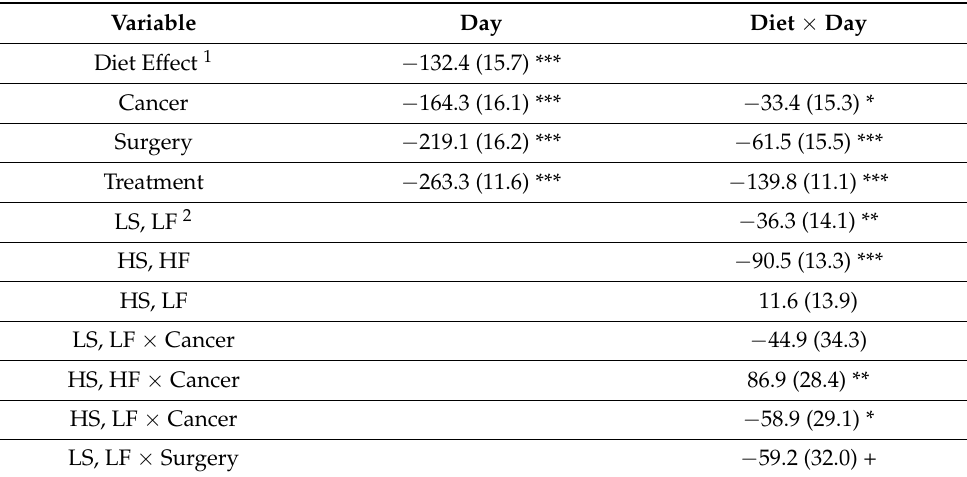
Table 1. Comparison of richness of ASV/per-sample modeled by day and diet. Number of taxa in observed time points and dietary combinations demonstrate significant effects of day, diet, and their interactions.